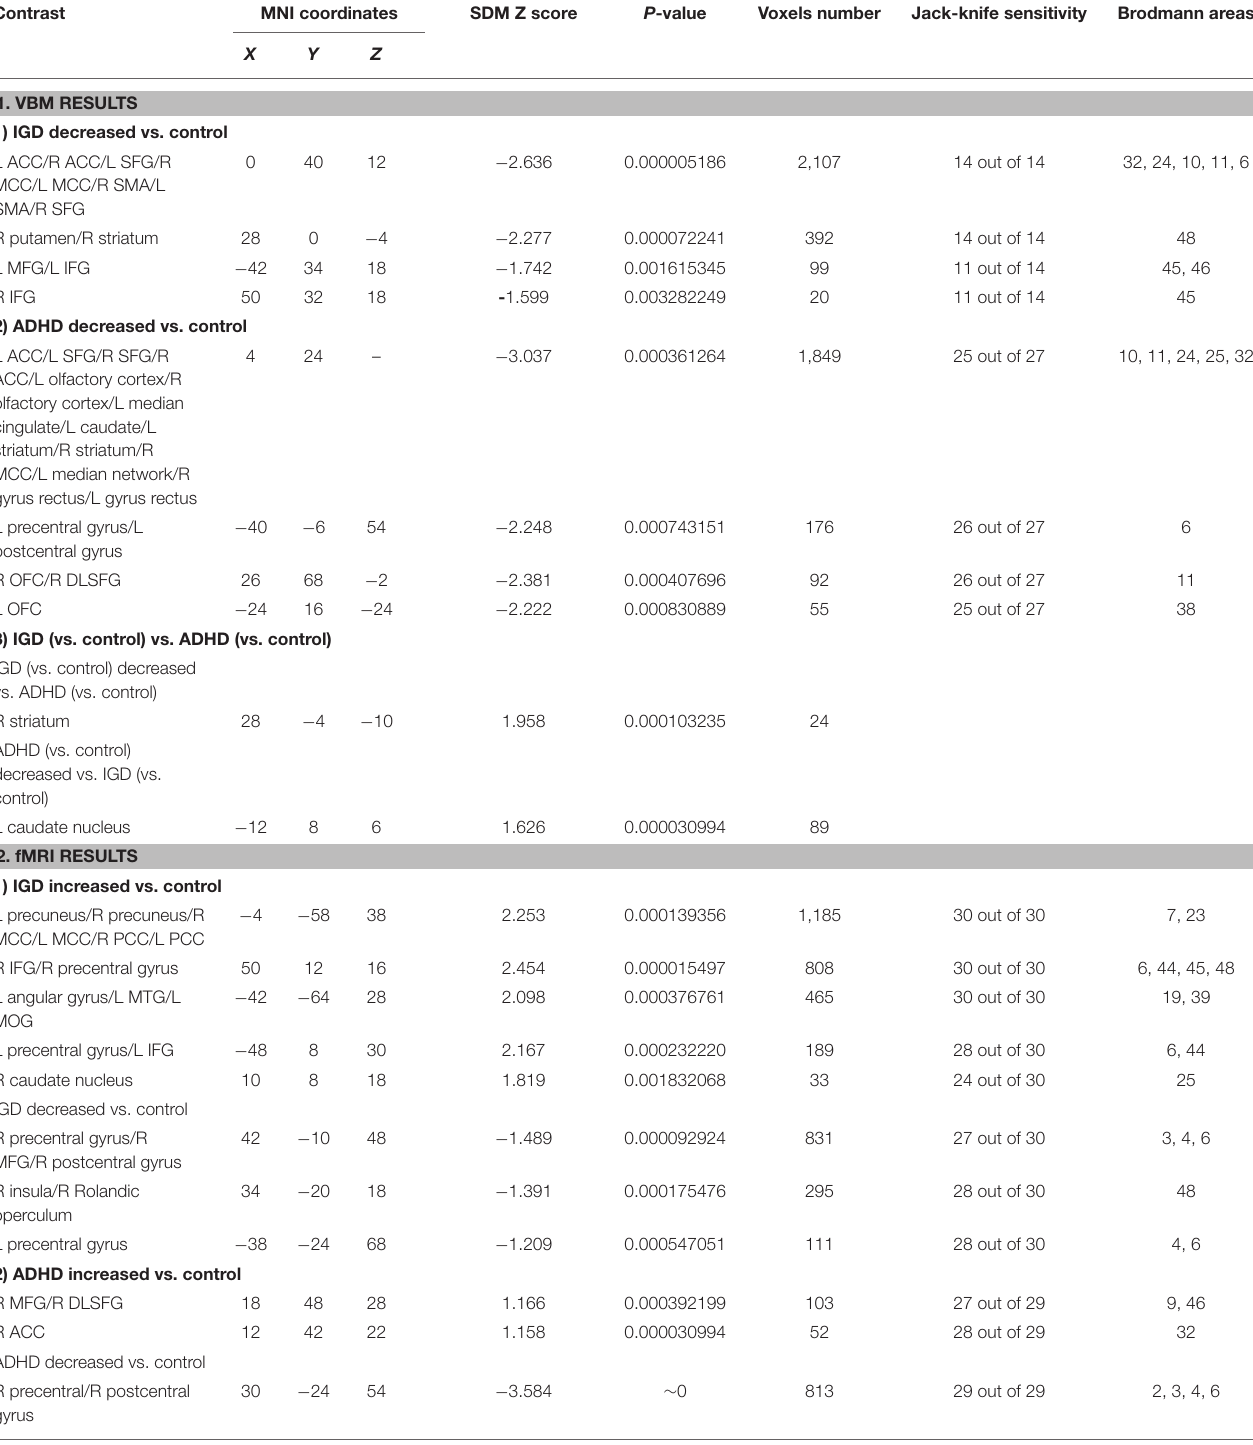
TABLE 3 | Meta-analysis results for voxel-based morphometry studies in IGD and ADHD. Contrast MNI coordinates SDM Z score P -value Voxels number Jack-knife sensitivity Brodmann areas X Y